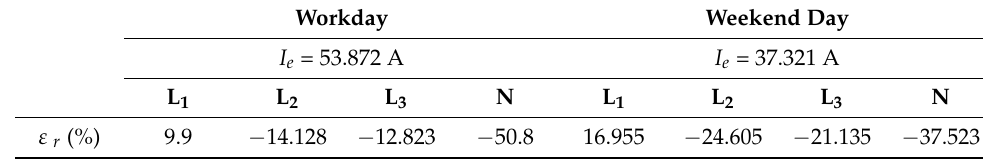
Table 4. The average RMS effective current I e and relative errors.